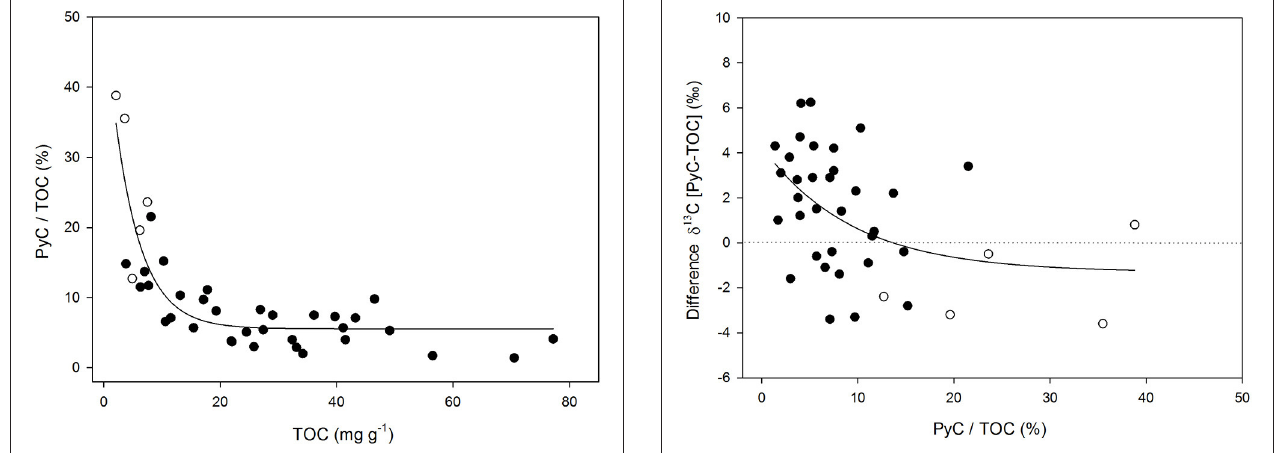
FIGURE 4 | Relationship between TOC content (mg g − 1 ) of bulk sediment samples and the relative contribution of PyC to TOC (%); r 2 0.74; p < 0.05. Open symbols correspond to samples with very coarse texture ( n = 5).